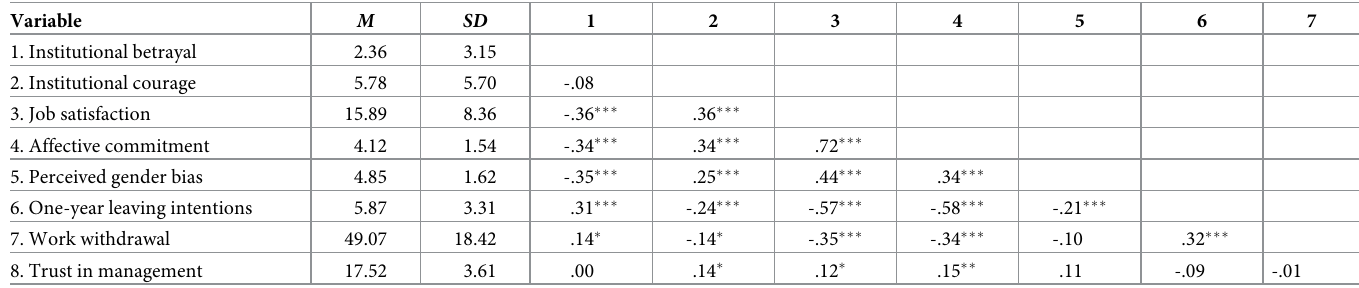
Table 3. Means, standard deviations, and bivariate correlations between IBQ, ICQ-Specific and employee workplace outcomes ( N = 317). Variable